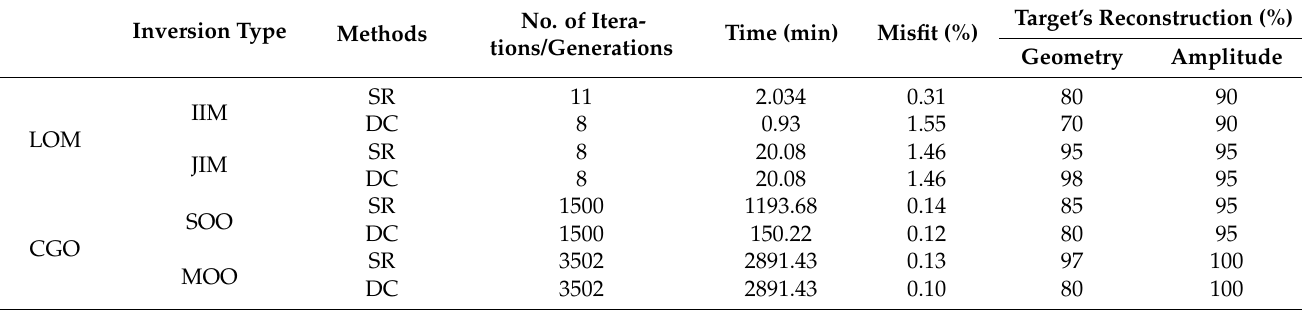
Table 4. Local and global optimization inversion results parameters for both DCR and SR (synthetic positive and negative anomalies model)